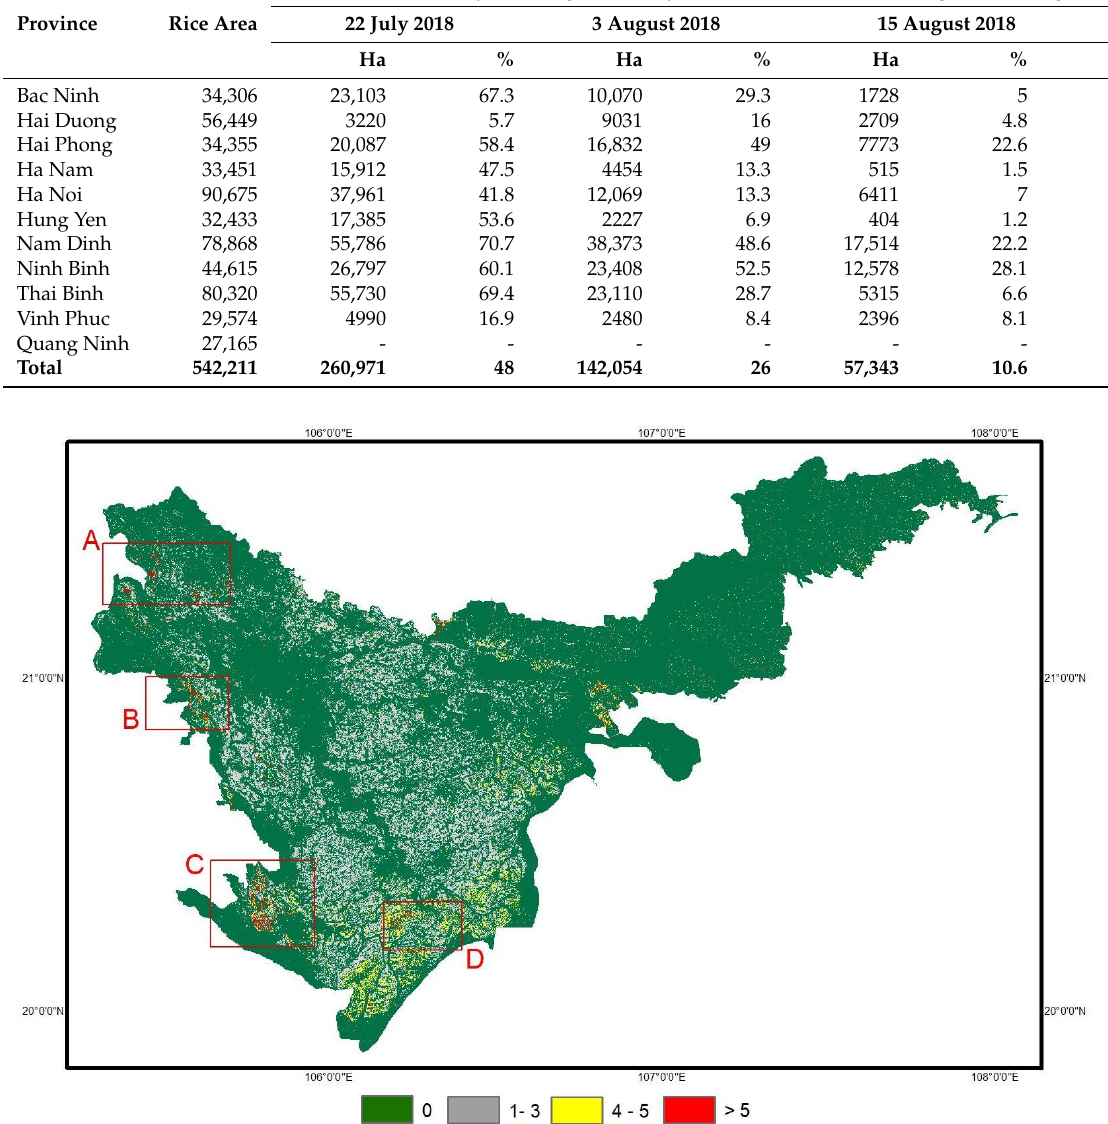
Figure 11. Flood frequency map for summer-autumn rice in 2018. ( A ) Lap Thach, Vinh Phuc, ( B ) Chuong My, Quoc Oai, Hanoi, ( C ) Nho Quan, Ninh Binh, ( D ) Nam